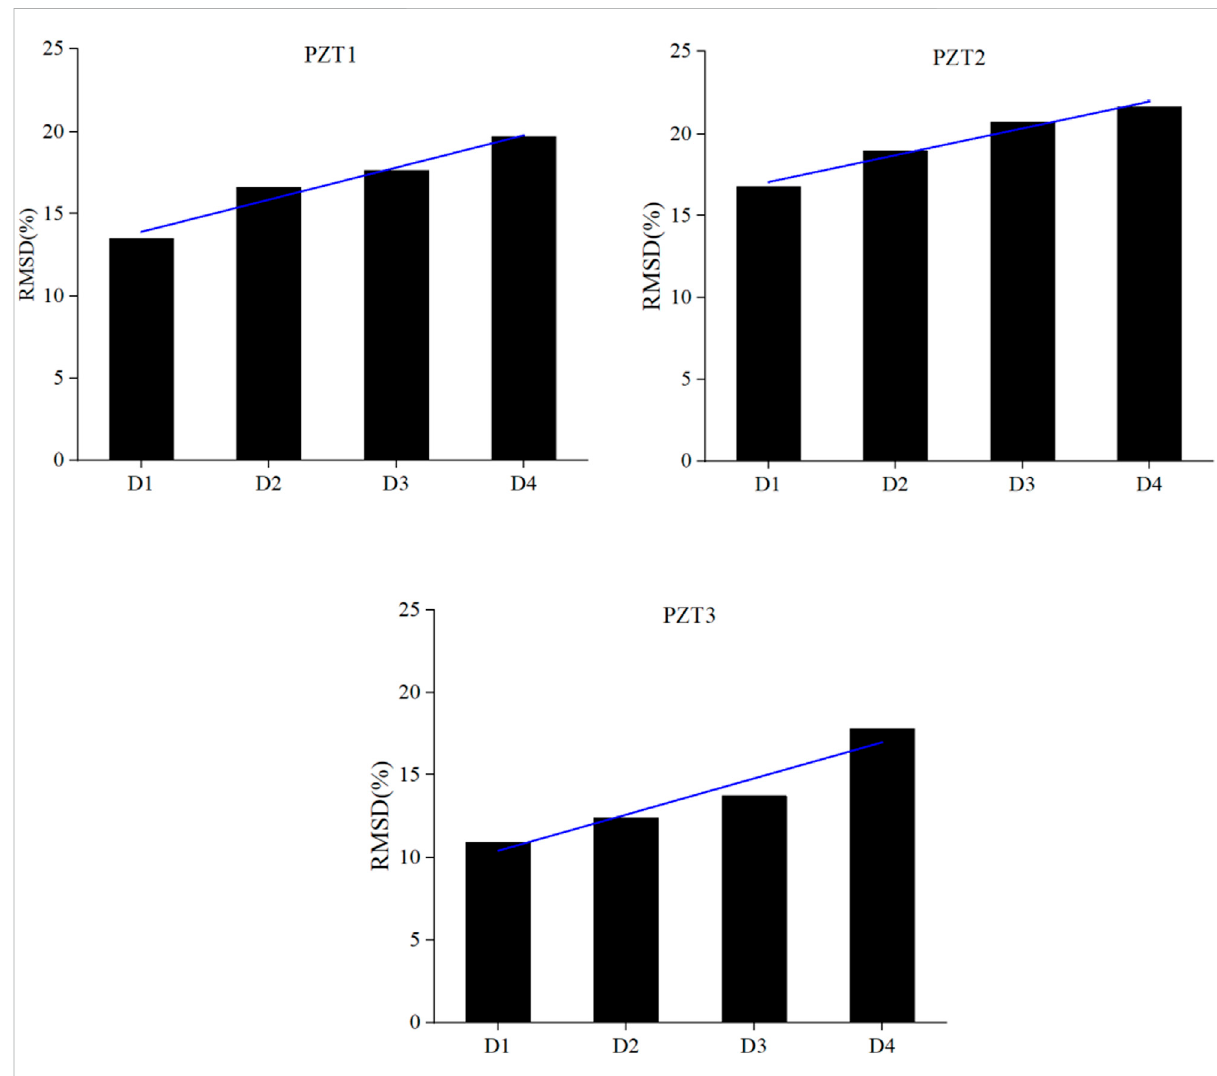
FIGURE 9 RMSD value of the PZT sensor of BE1 with the increase of